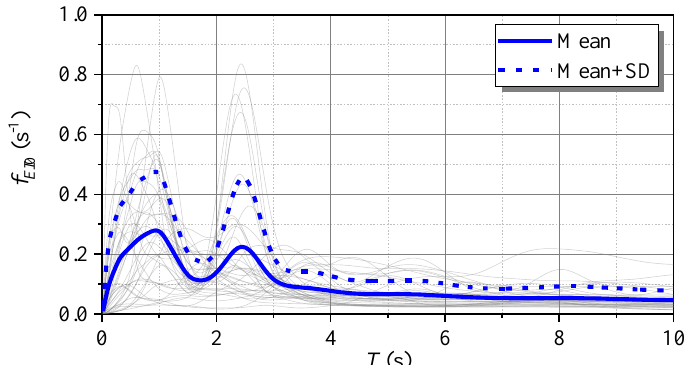
Figure 15. Mean and mean plus one standard deviation (SD) curves of normalized seismic-induced input energy spectra of SDOF element connected to a single dashpot.